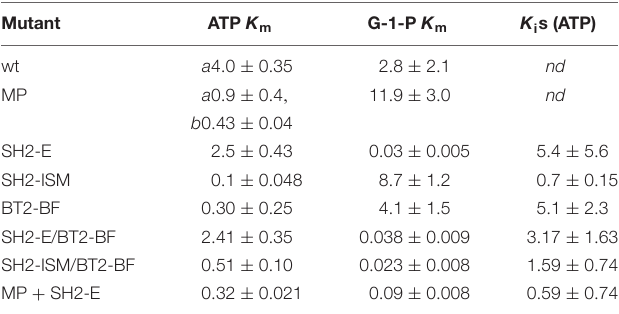
TABLE 4 | Kinetic values determined in the absence of 3-PGA of various AGPases.